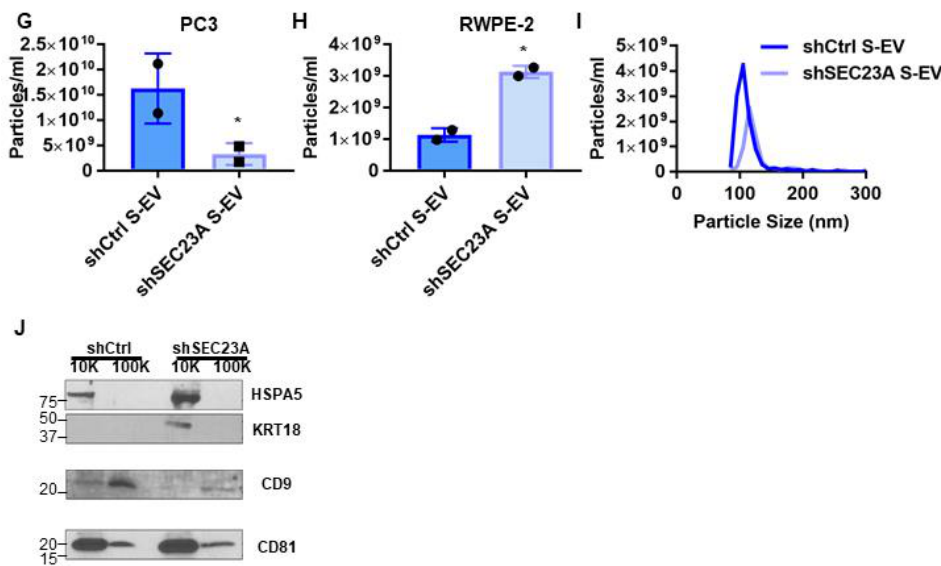
Figure 4. Inhibition of SEC23A induces L-EV shedding. ( A ) Quantification of L-EV shedding by TRPS in PC3 cells transiently transfected with SEC23A shRNA ( n = 3). ( B ) Quantification of L-EV shedding by TRPS after transient transfection with increasing doses of SEC23A shRNA ( n = 1). ( C ) Expression of SEC23A in PC3 cells stably expressing SEC23A shRNA. ( D – I ) Quantification of L-EV ( D , E ) and S-EV ( G , H ) shedding by TRPS in PC3 ( D , G ) and RWPE-2 ( E , H ) cells stably expressing SEC23A shRNA ( n = 2). ( H , I ) Size distribution of L-EV ( F ) and S-EV (I) from PC3 cells stably expressing SEC23A shRNA. ( J ) Western blot for EV markers from EV isolated from PC3 cells stably expressing SEC23A shRNA; * p < 0.05.